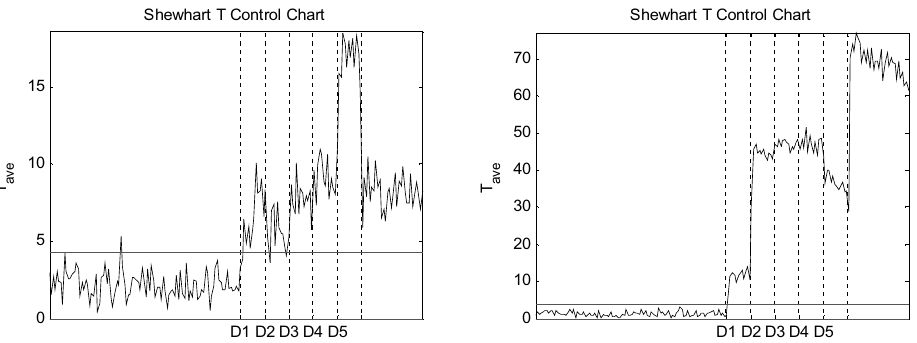
Fig. 4. Control charts for AR coefficients (left) and absolute transmissibilities (right). Damage location